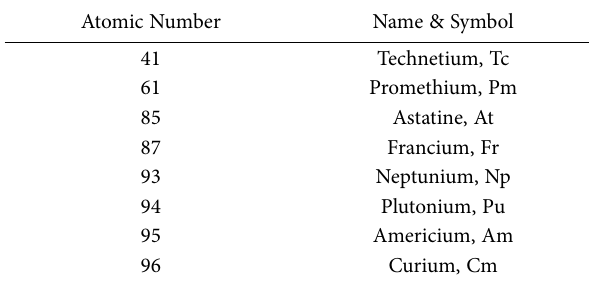
Figure 2. Newly synthesized elements named by the CNIC in 1949.